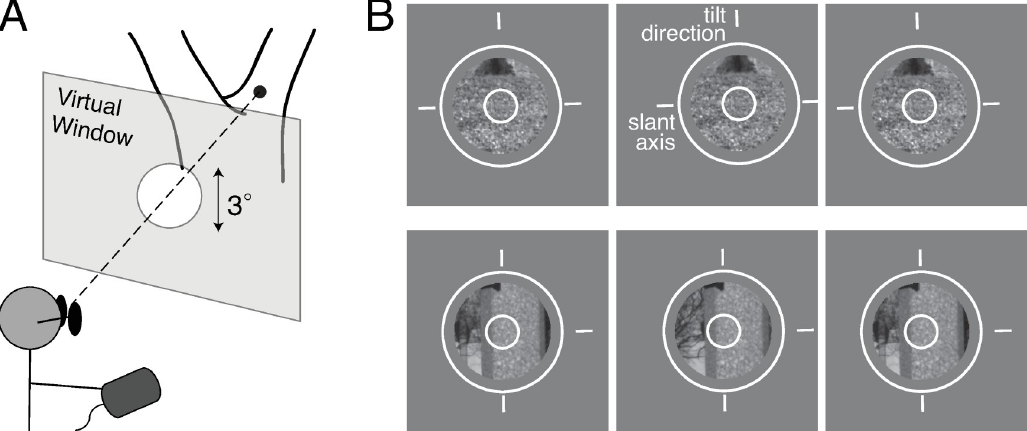
Fig 3. Human tilt estimation experiment. A Human observers binocularly viewed real-world scenes through a circular aperture with a 3 º diameter that was positioned stereoscopically in front of the scene. B Example of stimuli. Left-eye, right-eye, and left-eye images (for both uncrossed and crossed fusion). The patches are surrounded by a graphical probe (white circle and three tick marks). Observers rotated the probe to align the middle tick mark with the perceived tilt direction for the surface at the very center of the window; note that when the middle tick mark is aligned with the perceived tilt direction, the other two tick marks are aligned with the perceived slant axis.